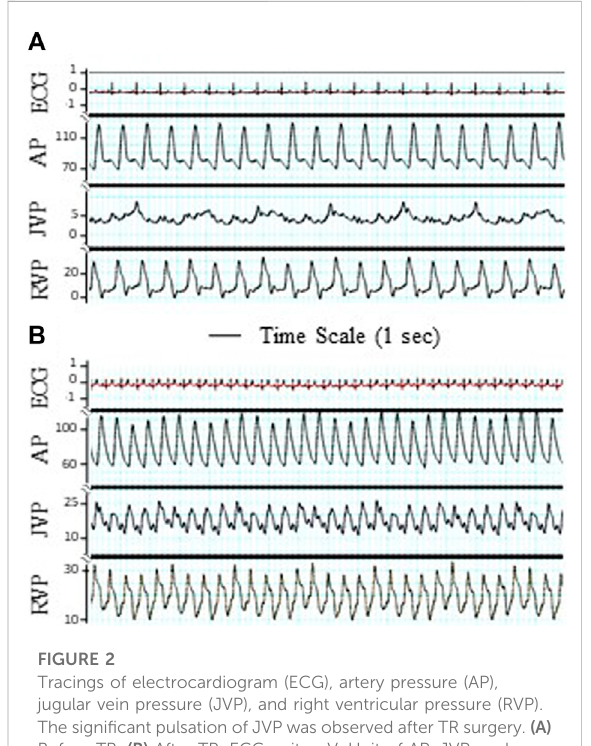
FIGURE 2 Tracings of electrocardiogram (ECG), artery pressure (AP), jugular vein pressure (JVP), and right ventricular pressure (RVP). The signi fi cant pulsation of JVP was observed after TR surgery. (A) Before TR. (B) After TR. ECG unit: mV. Unit of AP, JVP, and RVP: mmHg. Bar: Time scale for 1 s.